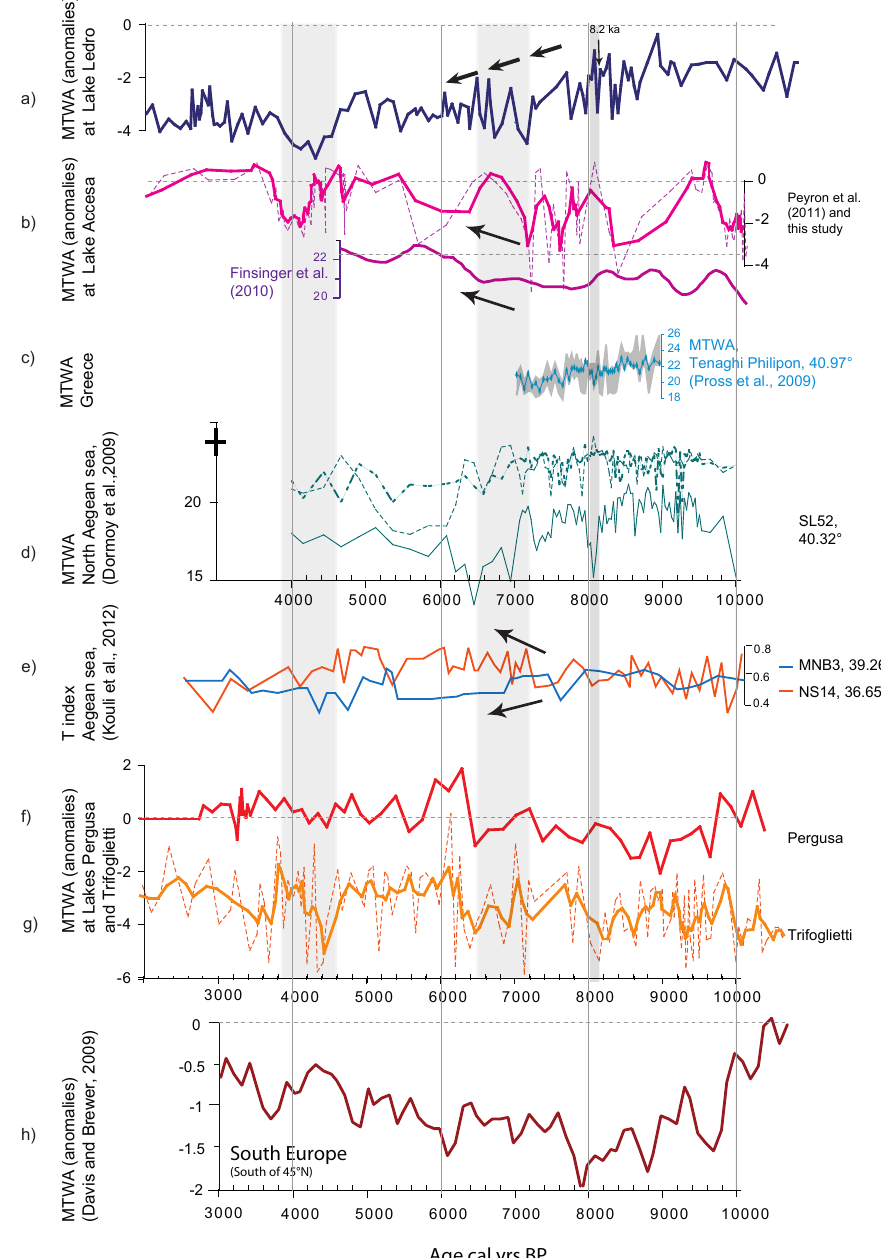
Fig. 5. Synthesis figure for selected Mediterranean temperature records. (a) Pollen-inferred temperature of the warmest month for Lake Ledro (as for Fig. 3), MAT only. (b) Pollen-inferred temperature of the warmest month for (1, pink curve) Lake Accesa littoral core, MAT only (as for Fig. 3), and (2, purple curve) Lake Accesa profundal core, WAPLS only (Finsinger et al., 2010). (c) Pollen-inferred temperature of the warmest month for Tenaghi Philippon, Greece, MAT only (Pross et al., 2009). (d) Pollen-inferred temperature of the warmest month for the marine core SL152, Aegean Sea, (Dormoy et al., 2009) with three methods (short dotted line: MAT; blue line: PLS; long dotted line: NMDS/GAM). (e) Pollen-based temperature index “T index” for the marine cores MNB3 (North Aegean Sea), and NS14 (South Aegean Sea), (Kouli et al., 2012). (f) Pollen-inferred temperature of the warmest month for Lake Pergusa (as for Fig. 3), MAT only. (g) Pollen- inferred temperature of the warmest month for Lake Trifoglietti (as for Fig. 3), MAT only; the curve of temperature is calculated with a moving average (bold curve) and raw values are also plotted (dotted curve). (h) Reconstruction of temperatures of the warmest month (anomalies) for Southern Europe based on pollen data from over 500 pollen sites from across Europe, MAT only (Davis and Brewer, 2009; Davis et al.,